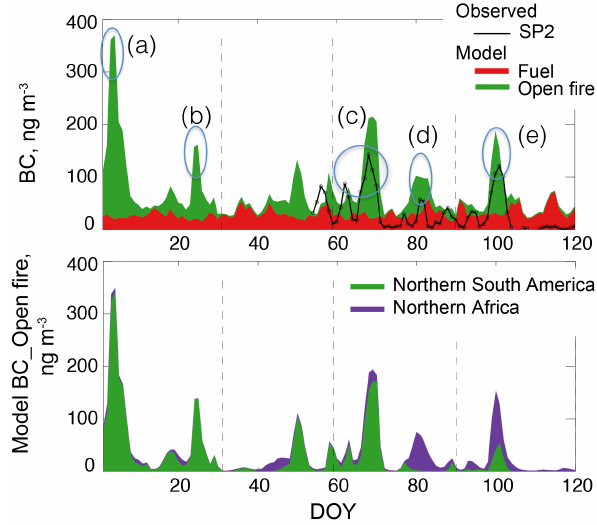
Figure 10. Time series of rBC and model BC concentrations at ATTO in January–April 2014. The top panel compares rBC with model BC separated into fuel (fossil fuel and biofuel) and open fire sources. The bottom panel further separates model fire BC by source regions. Circled peaks (a–e) are used for BC–CO analysis in Fig.